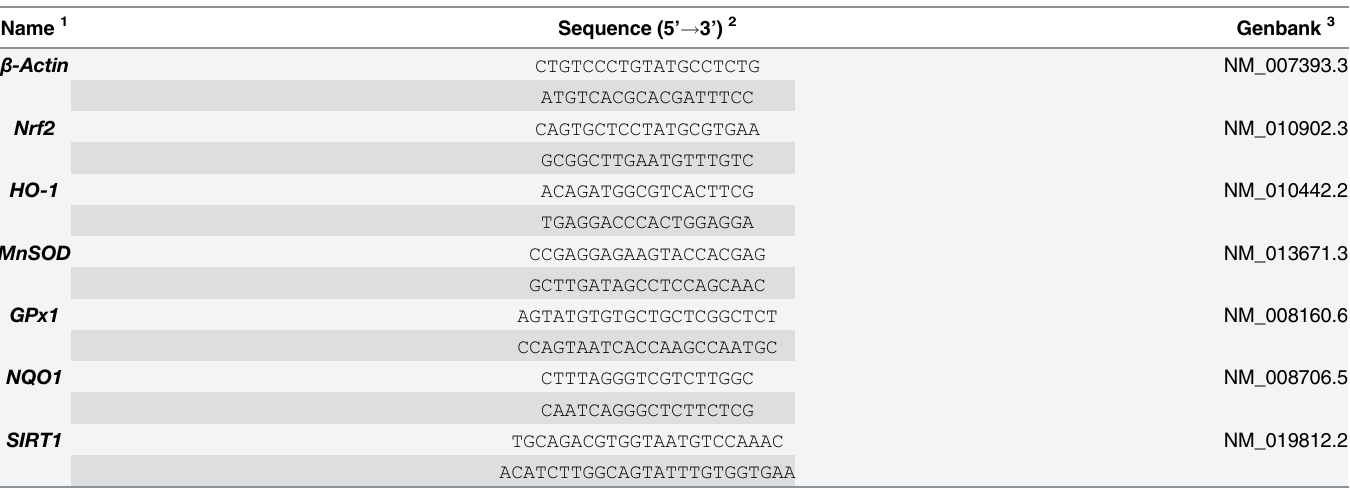
Table 1. Primer sequences used for Real-time PCR assay.